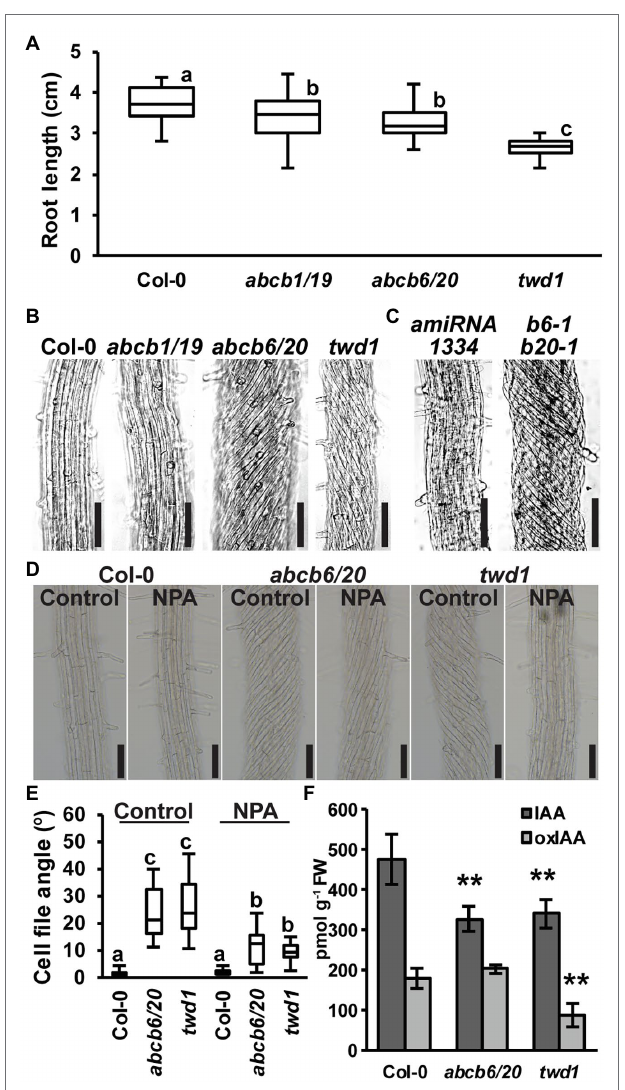
FIGURE 4 | Root phenotypes observed in twd1 can be attributed to loss of ABCB1/19 and 6/20 function. (A) 7-day primary root lengths ( n = 3 replicates of 10–13). (B,C) Bright field images of the distal elongation and maturation zone in 7-day seedling roots. Images in (B,C) were converted to black and white, and brightness and contrast were adjusted equally within each set to show cell files. (D) Treatment with 1 μ M NPA suppressed root twisting in abcb6/20 and twd1 . Brightness and contrast were adjusted equally to show cell files. (E) Quantification of cell file angles in (D) . Data shown are means ± SE ( n = 3 replicates of 10–11). (F) Quantification of IAA and oxIAA in 5.5-day light-grown roots. Data shown are means ± SD ( n = 4–5 independent pools of 25 mg tissue). Lowercase letters indicate statistical difference by all pairwise Student’s t -test ( p < 0.05). Asterisks indicate statistical differences by Student’s t -test (** p < 0.01). Scale bars: 100 μ